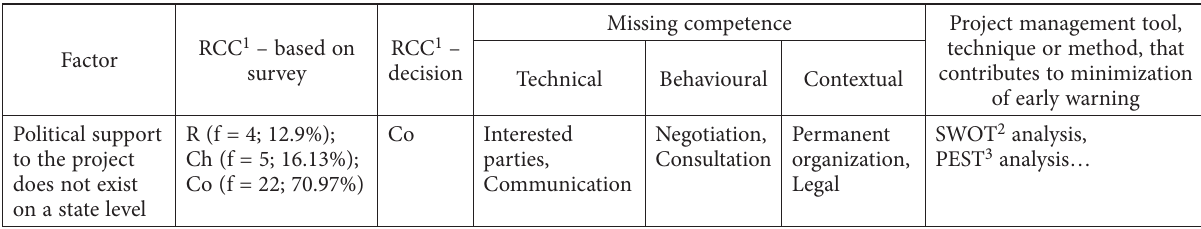
Table 2. An example of matching characteristics of each factor used as early response